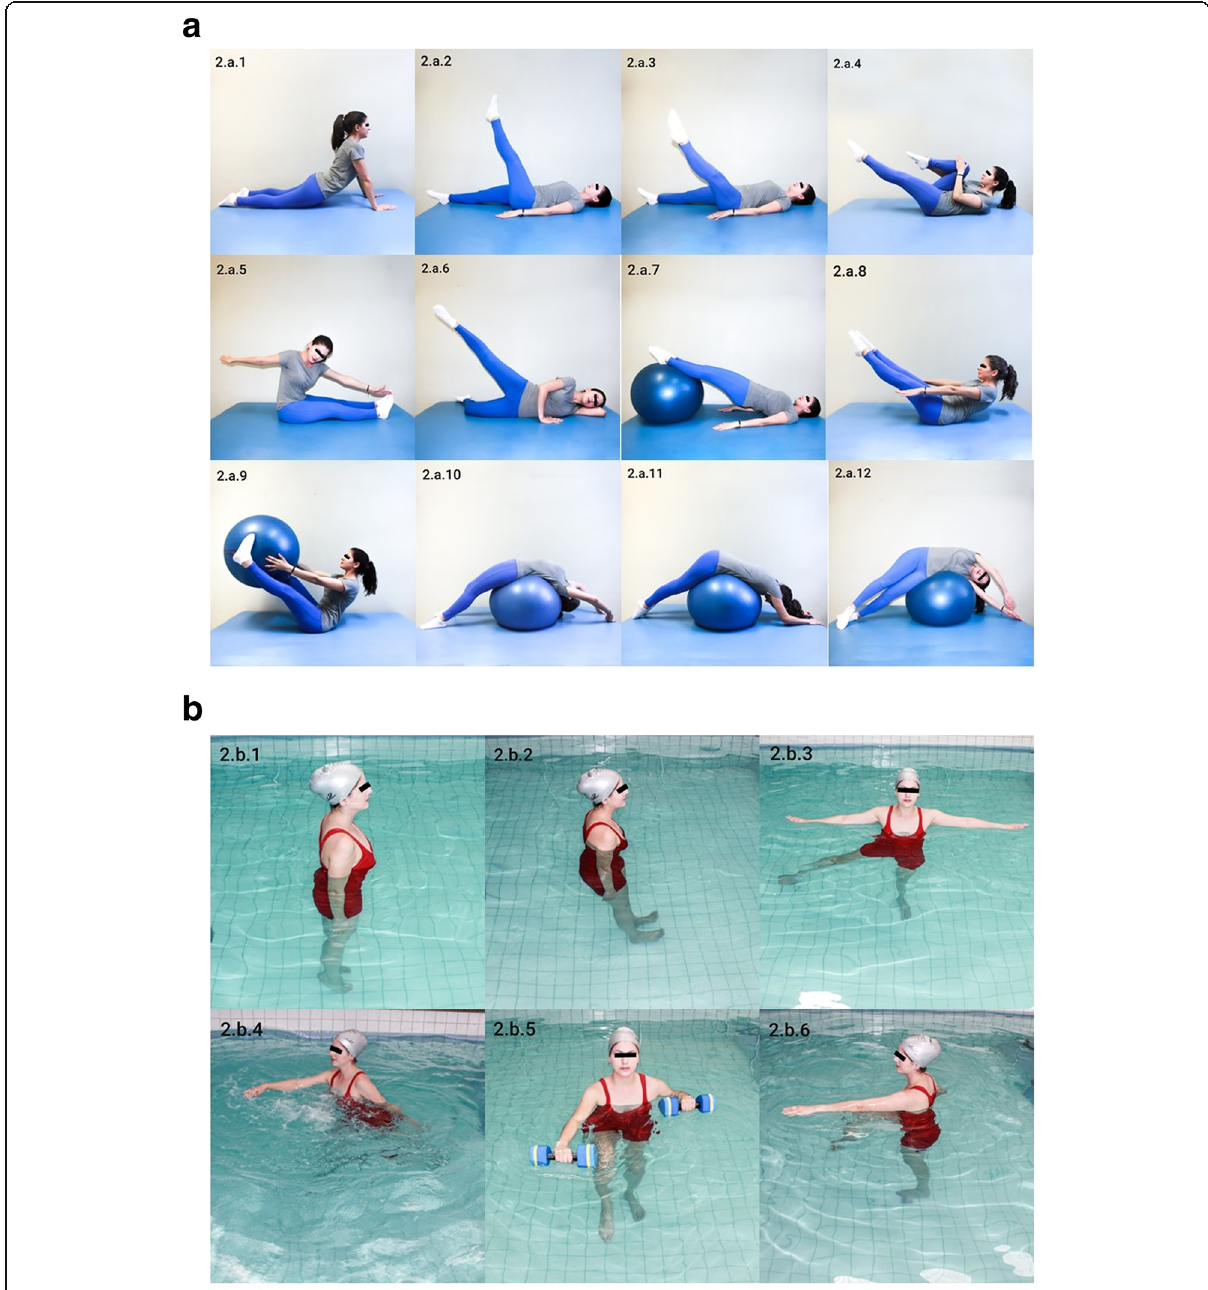
Fig. 2 Exercises program: a.1 to a.12 for Mat Pilates Group and b.1 to b.6 for Aquatic Aerobic Exercise